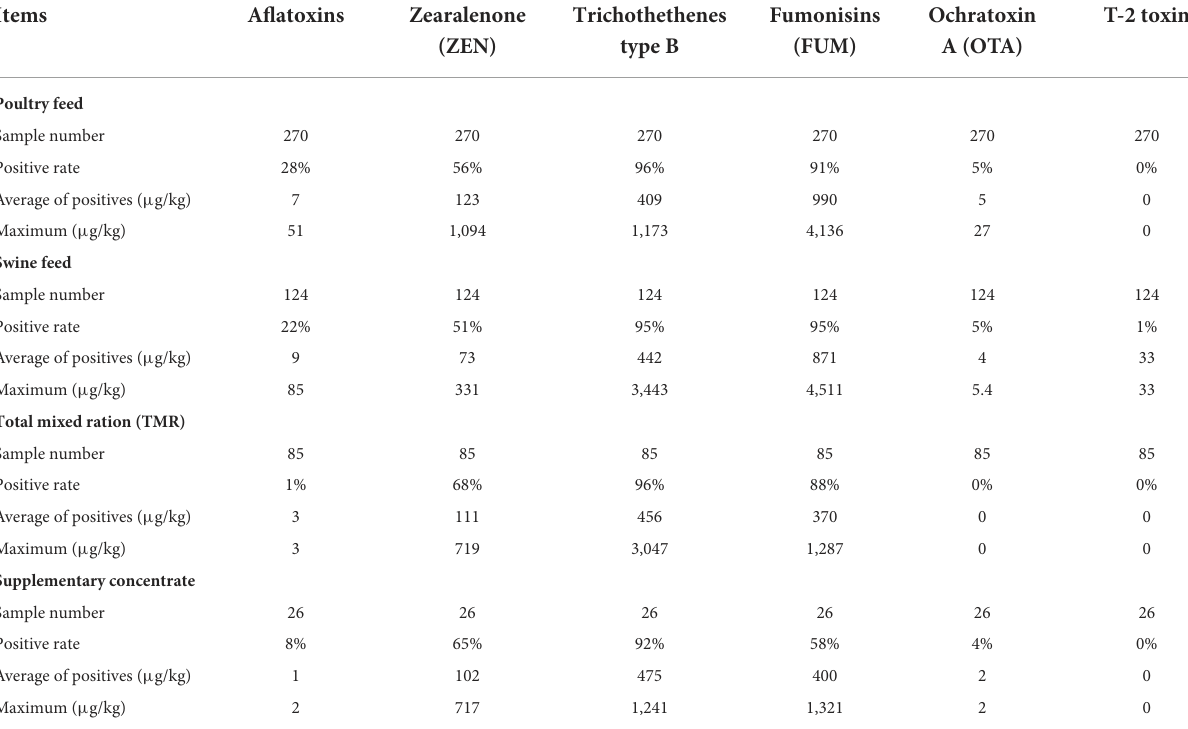
TABLE 5 Mycotoxin occurrence in finished